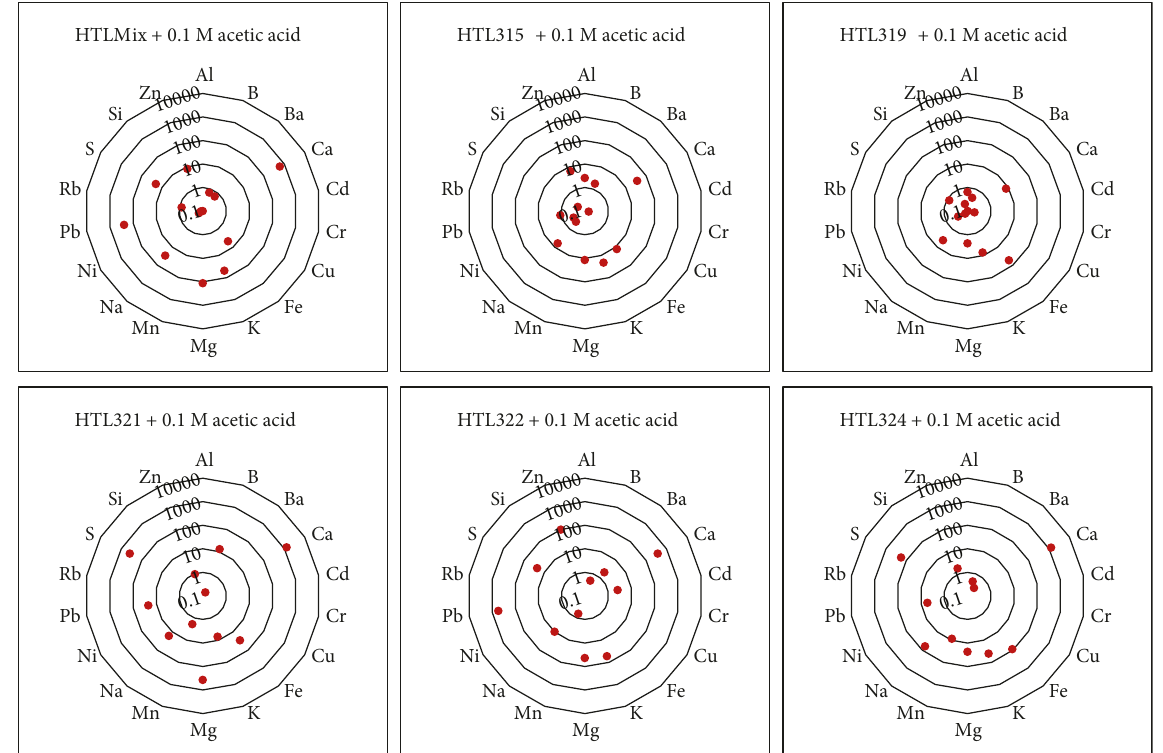
Figure 15: Elemental composition of each leachate reacted with 0.1M acetic acid at 250 ° C temperature under 250bar pressure in the fl ow- through reactor after 36, 37, 42, 27, 38, and 48 minutes, respectively (absence of data points re fl ects concentrations below the limits of